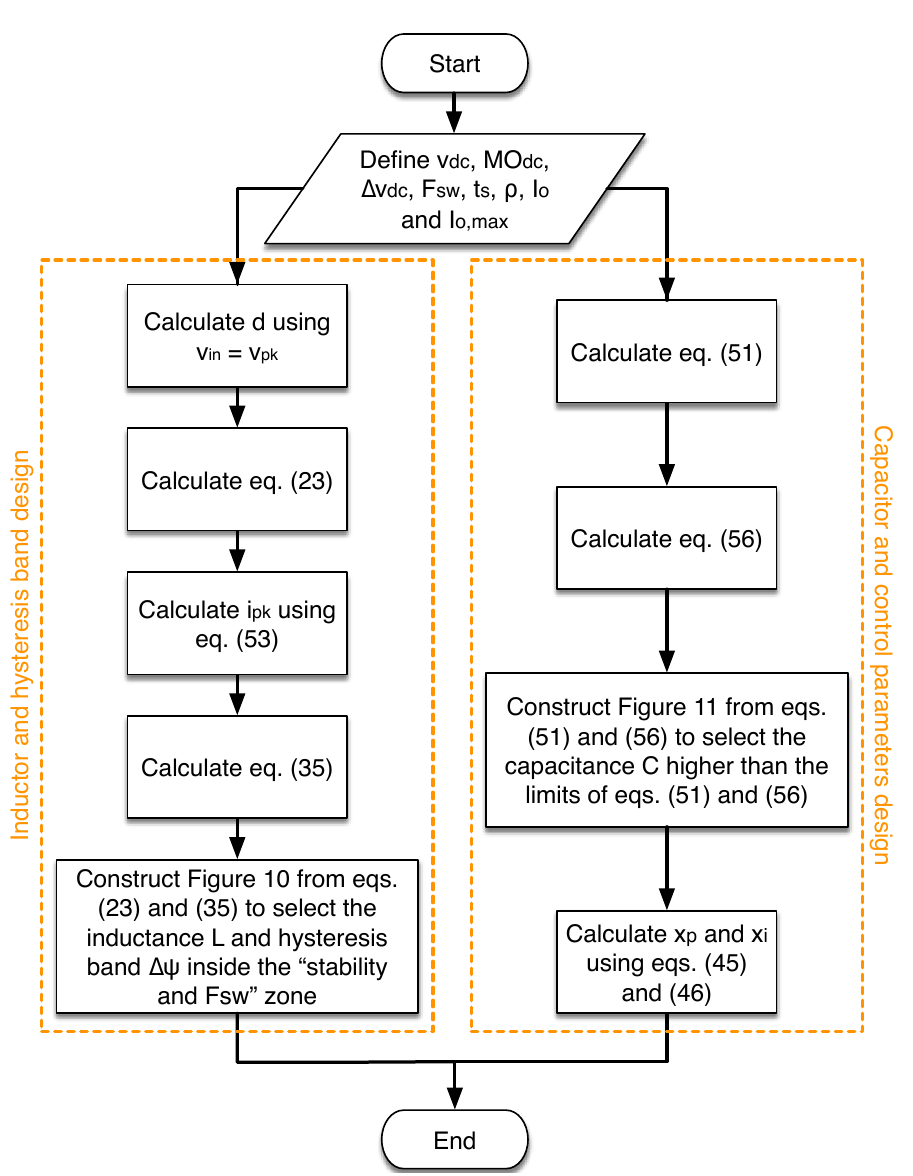
Figure 12. Flowchart of the design